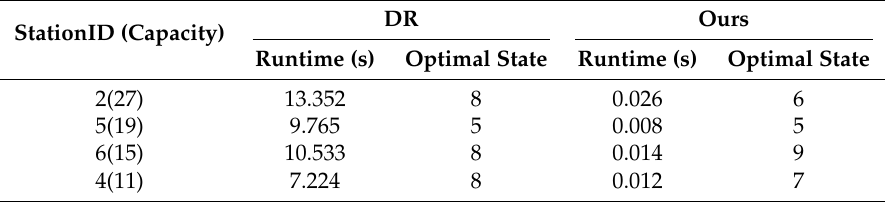
Table 3. Comparison of runtime of calculating the optimal